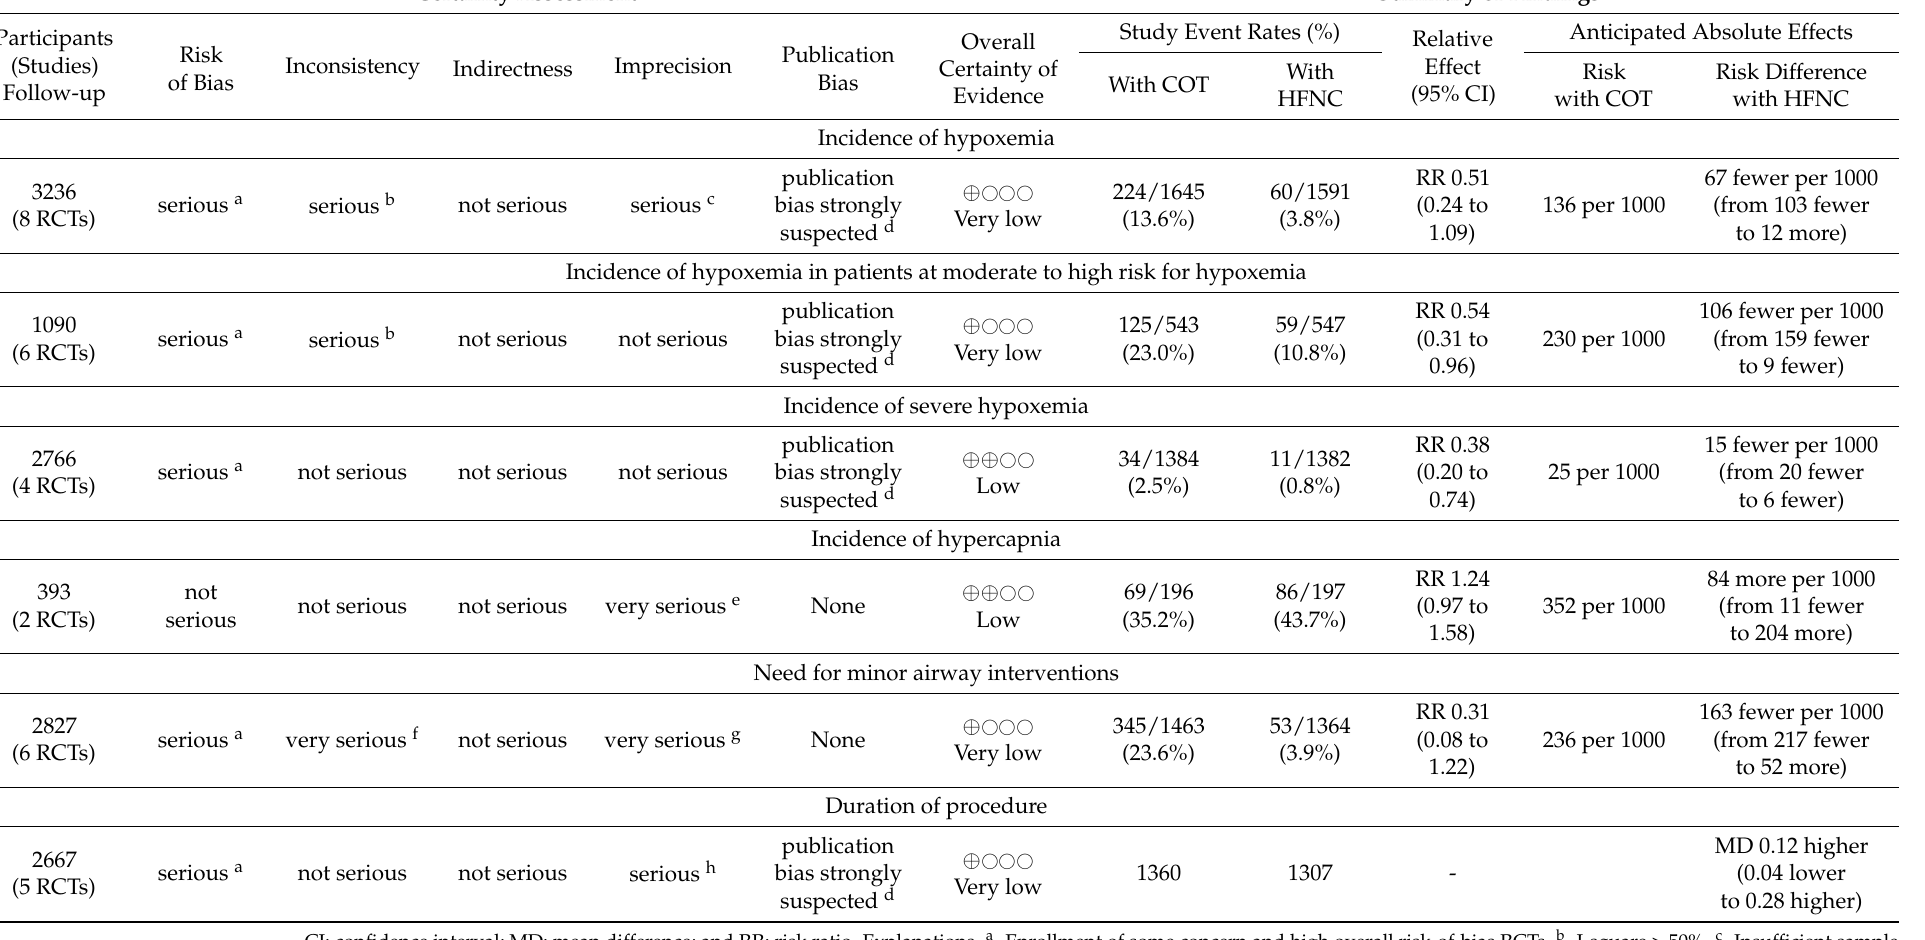
Table 2. Certainty of evidence: HFNC compared to COT for patients receiving gastrointestinal endoscopies. Certainty Assessment Summary of